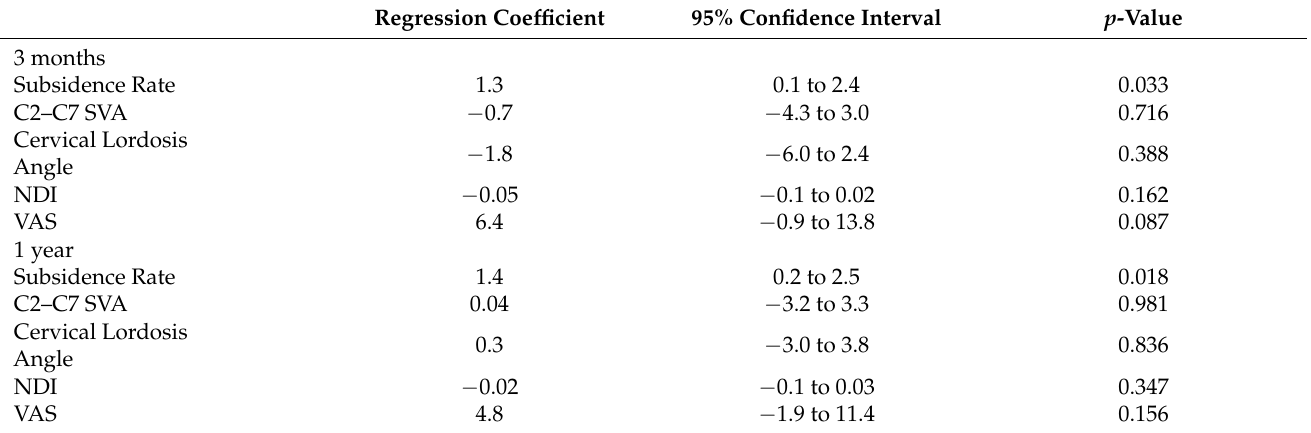
Table 3. Regression analysis on post-operative outcomes between short and medium plate to adjust for sex and diagnosis.